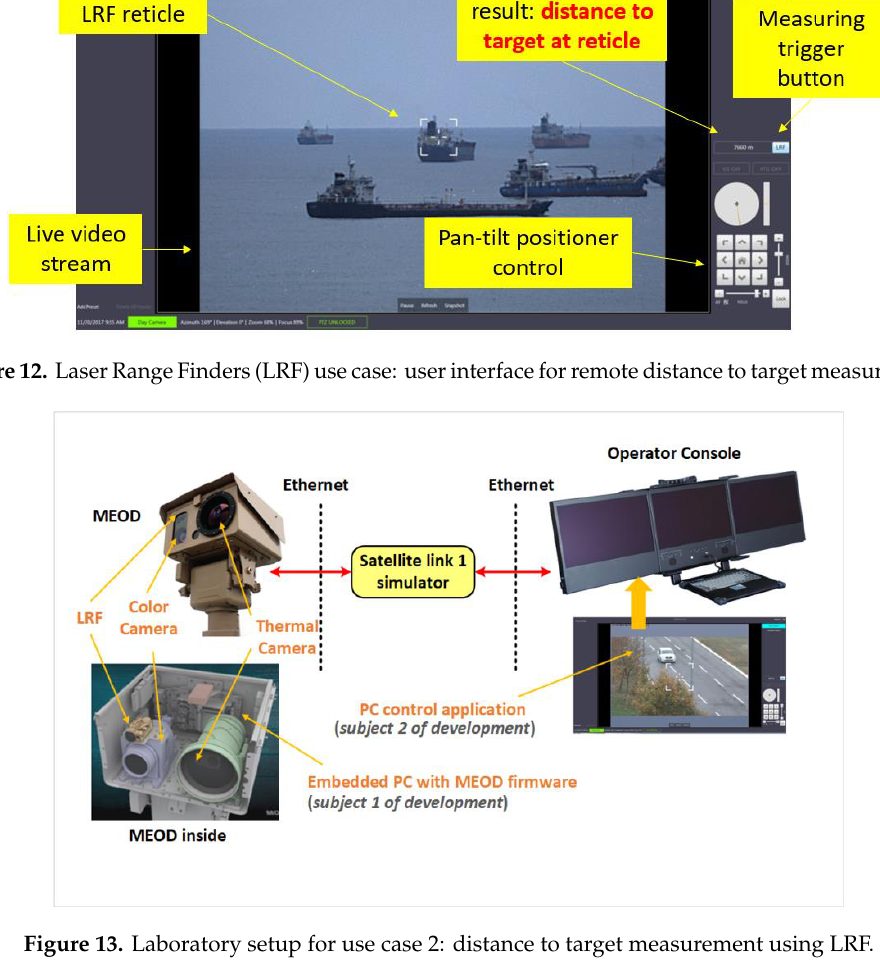
Figure 13. Laboratory setup for use case 2: distance to target measurement using LRF.